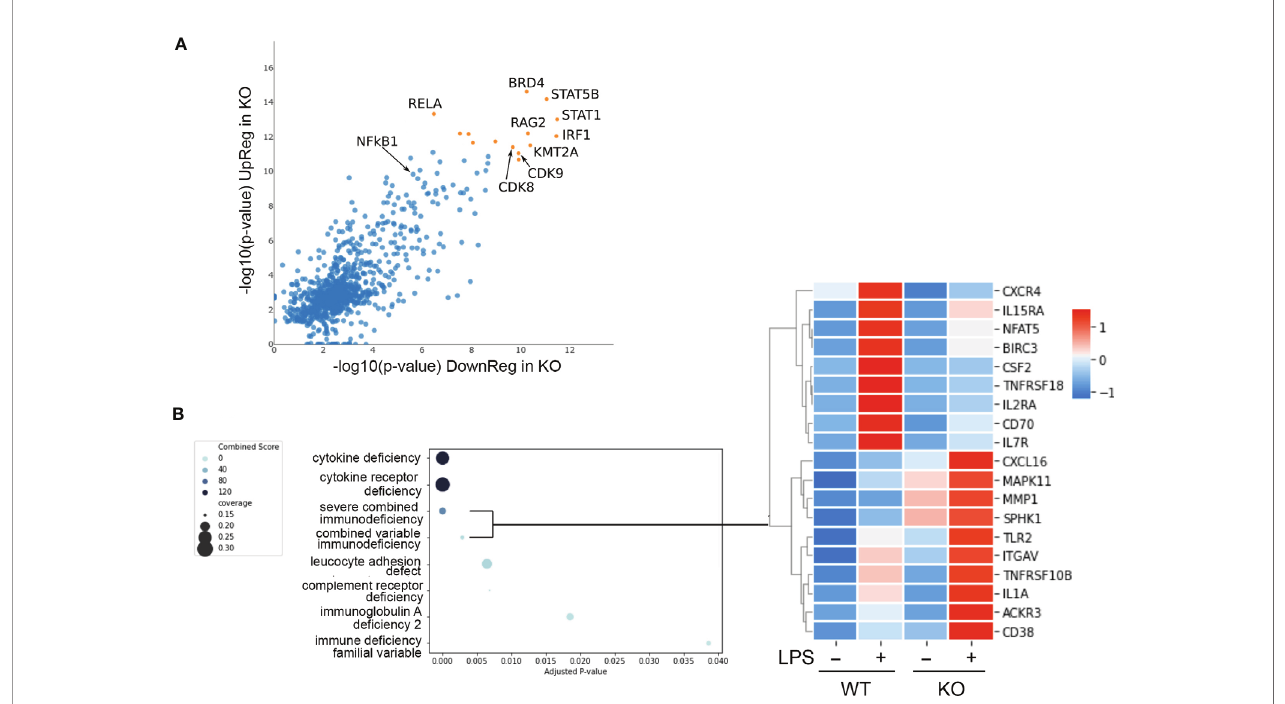
FIGURE 5 | NFKB1 transcription factor network and disease associations. (A) Lisa analysis identifying transcription factors associated with the expression LPS dependent of genes differentially expressed in NFKB1 -/- cells (p < 0.01). Top most signi fi cant factors indicated by orange symbols. (B) Identi fi cation of disease associated gene signatures in the GeneRif database with signi fi cant similarity to the transcriptional signature of LPS-stimulated NFKB1 -/- cells (q value < 0.05). Heatmap on right shows selected genes associated with the severe combined and common variable immunode fi ciency disease signatures, Z-score